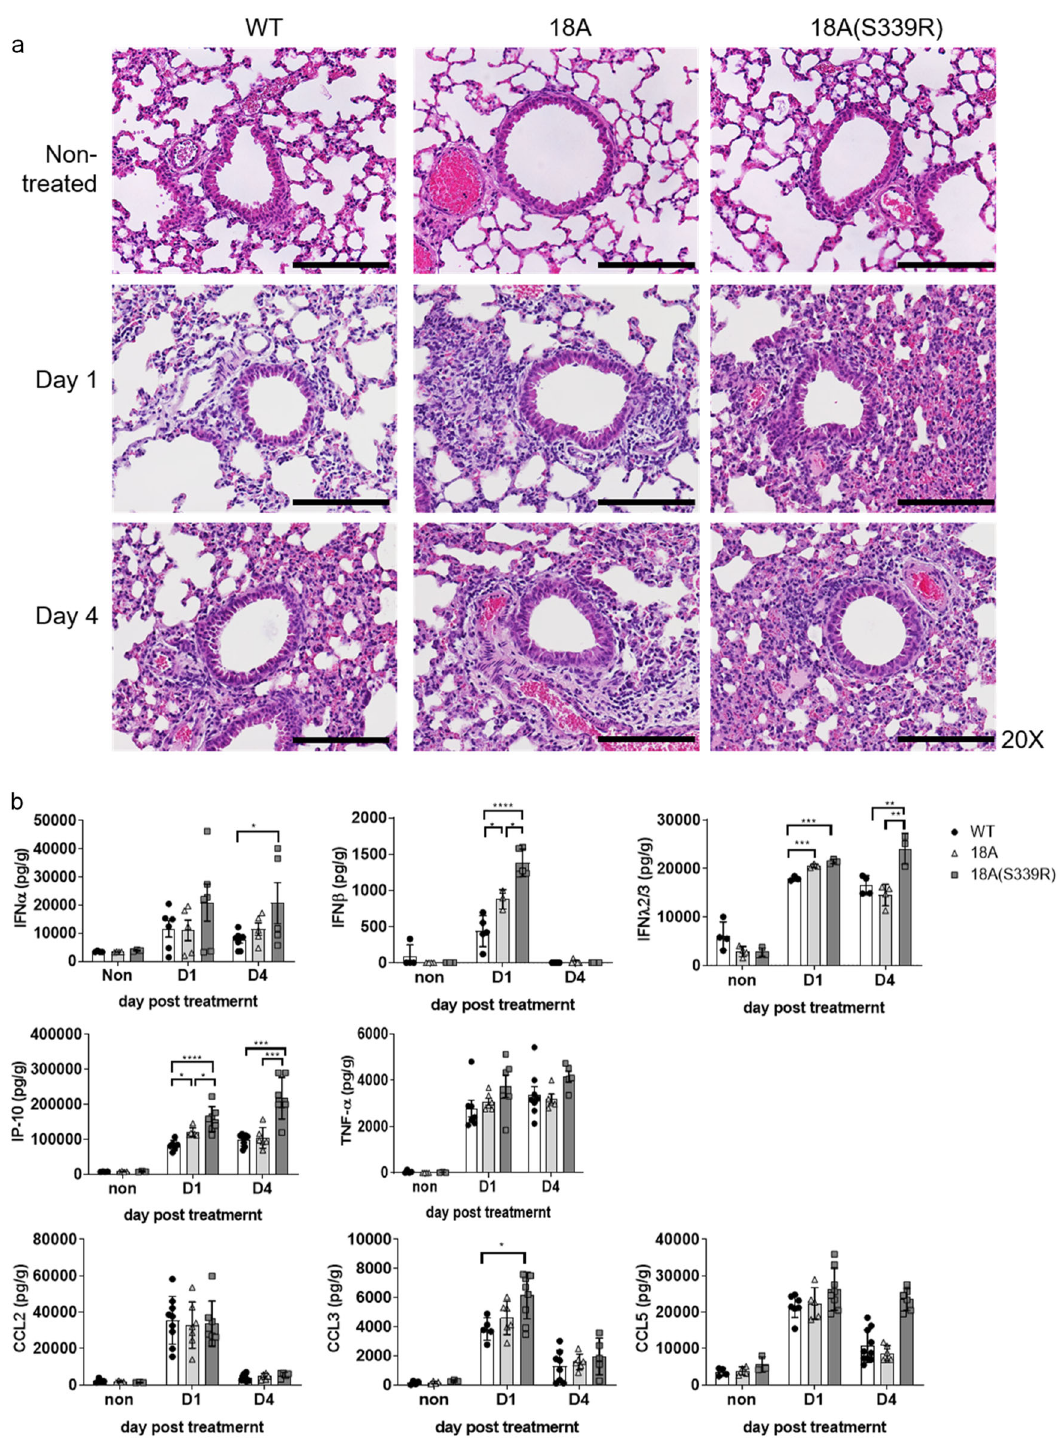
Fig. 7 CLEC18 enhances poly (I:C)-induced in fl ammatory reaction in vivo. WT, ROSA-CLEC18A, and ROSA-CLEC18A(S339R) mice were inoculated with HMW poly (I:C) (30 μ g per mouse) via intranasal route, and then were sacri fi ced at day 1 (D1) and 4 (D4) post treatment. Lung sections were subjected to hematoxylin and eosin (H&E) staining ( n = 3 – 6) ( a ), and cytokine in bronchoalveolar lavage was determined by ELISA ( n = 3 – 8) ( b ). pIC: poly (I:C). One- way ANOVA was performed. * P < 0.05, ** P < 0.01, *** P < 0.001 and **** P < 0.0001 for WT group versus groups of CLEC18A or CLEC18A(S339R). Scale bar: 200 μ M. Determination of virus titers in lung tissue . Lungs isolated from IAV-infected using the TriRNA Pure Kit (Geneaid, Catalog No.TRP100), and fi rst-strand mice were homogenized with a homogenizer (MagNA Lyser Instrument, Roche cDNA was synthesized using a RevertAid First-Strand cDNA Synthesis Kit Applied Science) in 0.7 ml PBS on ice, followed by centrifugation at 11,000 r.p.m. (Thermo Scienti fi c) as per the vendor ’ s instruction. Quantitative real-time PCR analysis was performed using the LightCycler ® 480 System (Roche Applied for 10min at 4°C. Supernatants were diluted serially in DMEM, and virus titers Science). were determined by plaque assay on con fl uent MDCK cells. COMMUNICATIONS BIOLOGY| (2021) 4:229